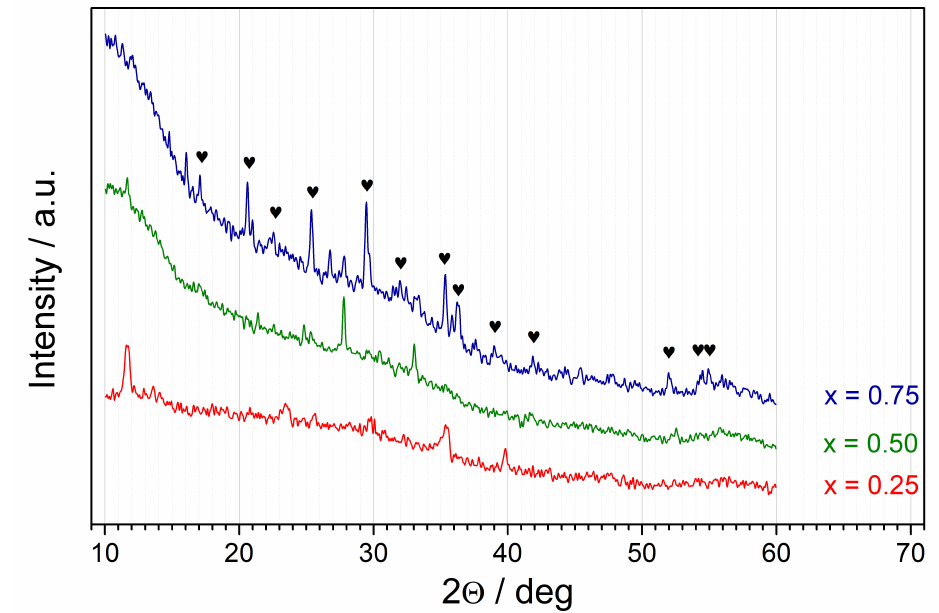
Figure 2. XRD patterns for synthesized Li(Fe 1 − x Mn x ) 0.88 V 0.08 PO 4 samples measured at room temper- ature. Diffraction lines ascribed to Li(Fe 0.25 Mn 0.75 )PO 4 reference pattern (ICDD card no. 04-024-8018) are marked with hearts.